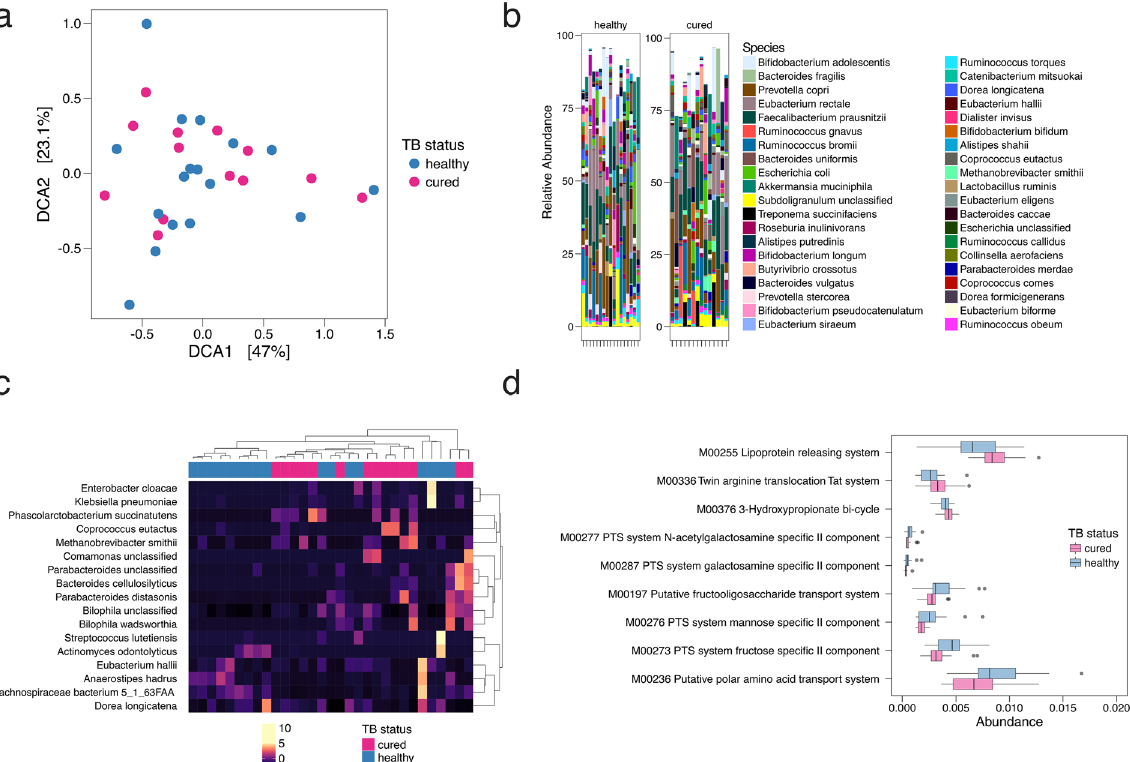
Figure 5. TB treatment induces a lasting alteration in microbiome structure and function. ( a ) DCA ordination plot on metagenomic taxonomy data in healthy (combined Mtb -uninfected and LTBI community controls) and cured individuals. ( b ) Comparative abundance plots between healthy Haitian individuals and cured subjects showing the top 40 most abundant species between the two groups. ( c ) Unsupervised hierarchical clustering of significantly altered taxa. ( d) Abundance of significantly different KEGG modules between healthy and cured